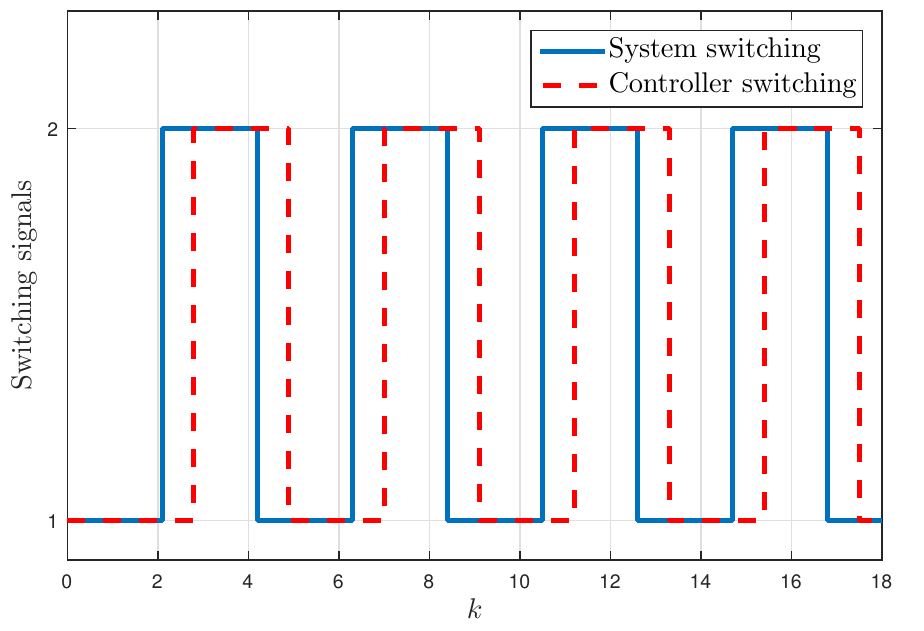
Figure 2. The system and controller switching signal.